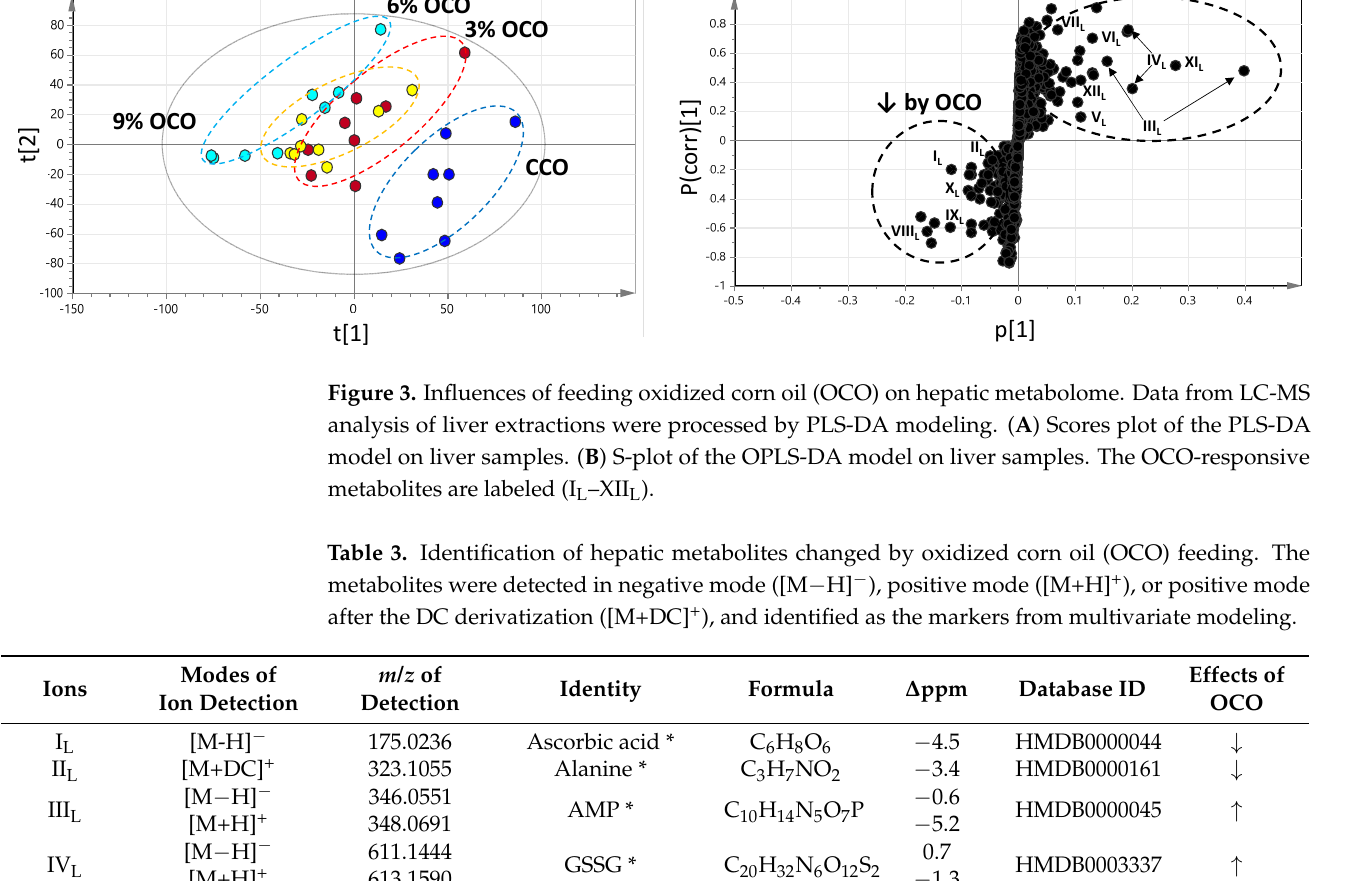
methods. The scores plot of the hepatic metabolome in the PLS-DA model showed a dose-